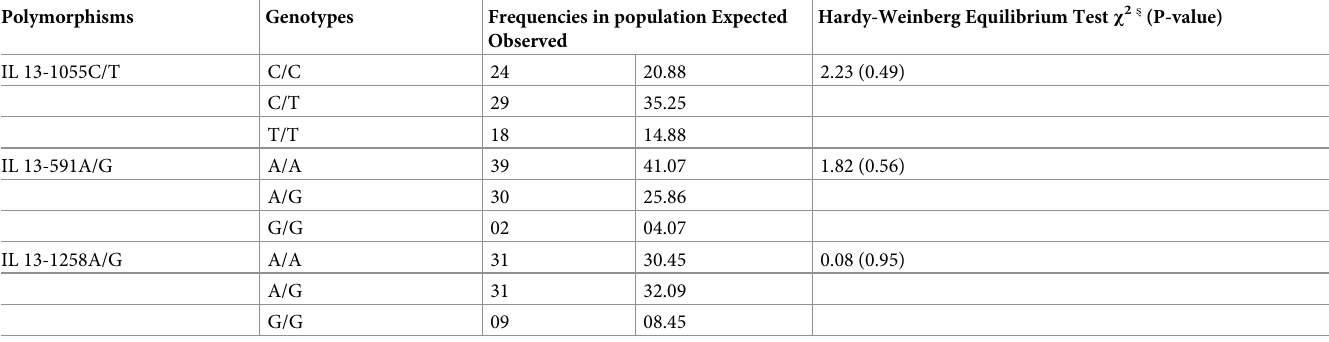
Table 2. Determination of IL-13 gene polymorphism adherence to the Hardy-Weinberg Principle.